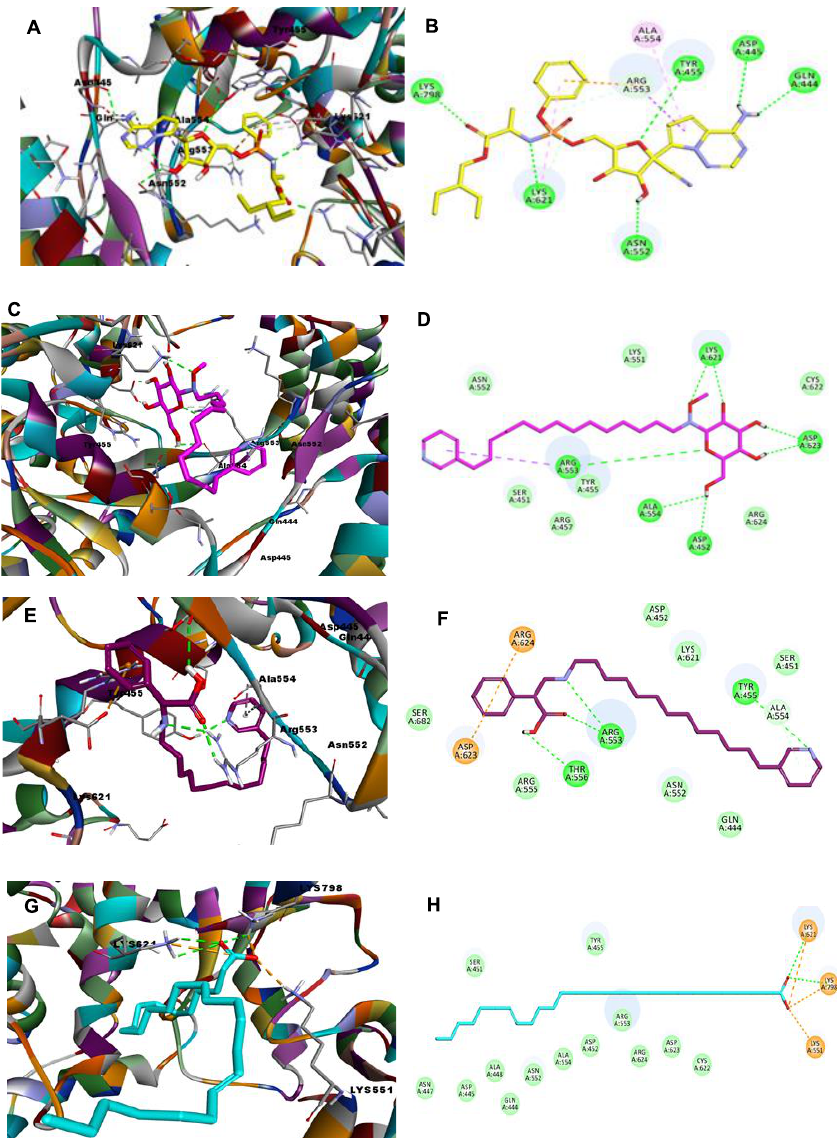
Figure 2. Depiction of 3D and 2D binding modes of remdesivir ( A , B ) and compounds 12 ( C , D ), 1 ( E , F ), and 11 ( G , H ) into the active site of SARS-CoV-2 RdRp (PDB entry: 6NUR). The data revealed that compound 1 has a CDOCKER energy of −45.4891 and a CDOCKER interaction energy of −51.245; the high CDOCKER energy draws particular attention to this compound. In addition, it is involved in the formation of four H-bonds, as is remdesivir. Compound 1 forms hydrogen bonds with the important amino acid res- idues Arg553 (2), Thr556, and Tyr455, and undergoes two pi-cation interactions with Arg624 and Asp623 and one hydrophobic interaction with Asp623, as illustrated in Figure 2E,F. Compound 11 (Figure 2G,H), is engaged in the formation of two hydrogen bonds with the amino acid residues Lys621 and Lys798, in addition to three attractive charge and salt bridge interactions, which may explain its lower CDOCKER energy (−40.4527) and CDOCKER interaction energy (−55.0797). Compounds 8 , 7, and 9 showed low binding energy, as shown in Table S1, and formed three H-bonds, as shown in Figure 3A–F. Compound 10 engaged in the formation